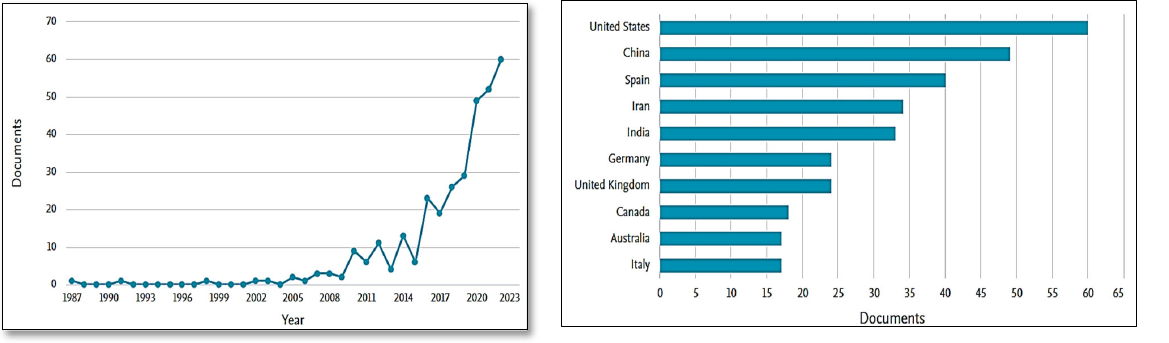
Fig. 3b. Countries that carried out research with the words intelligence”, “artificial”, for “management”, “resource” and “Hydric”